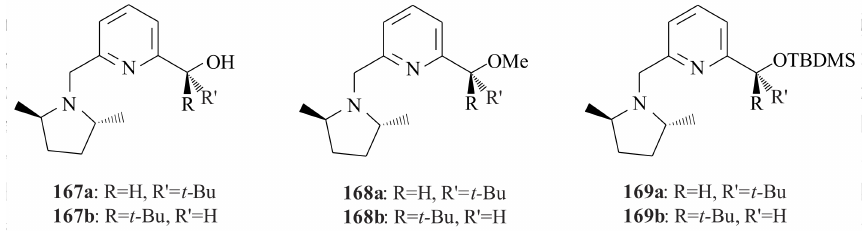
Figure 37. Pyrrolidinopyridines with alkoxy substituents at the 6-position of the pyridine ring. Table 12. Enantioselective allylation of rac-1,3-diphenylpropenyl acetate with malonate employing 2-pyrrolidinopyridines 167 – 169 . Ligand Yield (%) ee (%) Conf. 167a 27 167b